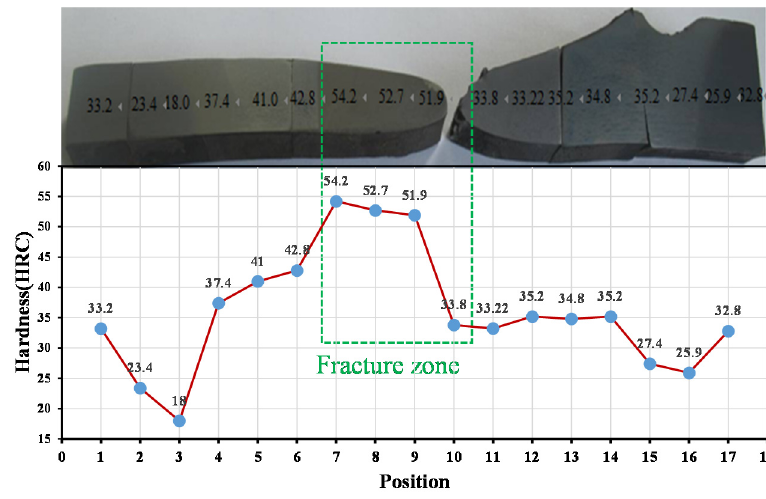
Figure 5. Variation in hardness on the sample section.